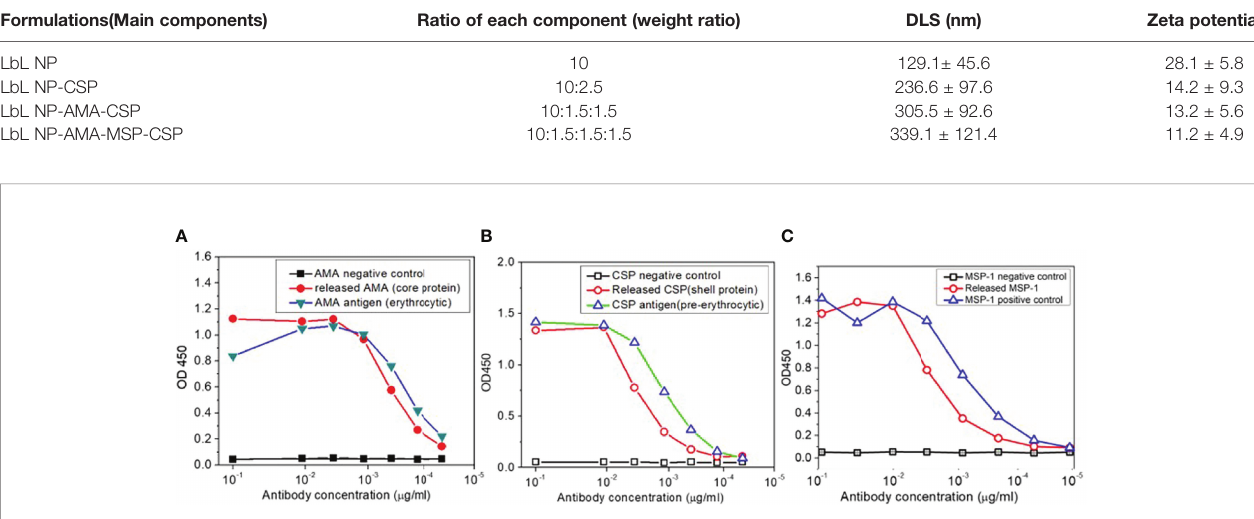
FIGURE 5 | (A) ELISA antigenicity test for comparison of released AMA, (B) CSP and (C) MSP-1 antigens from TMC nanoparticles with corresponding malaria